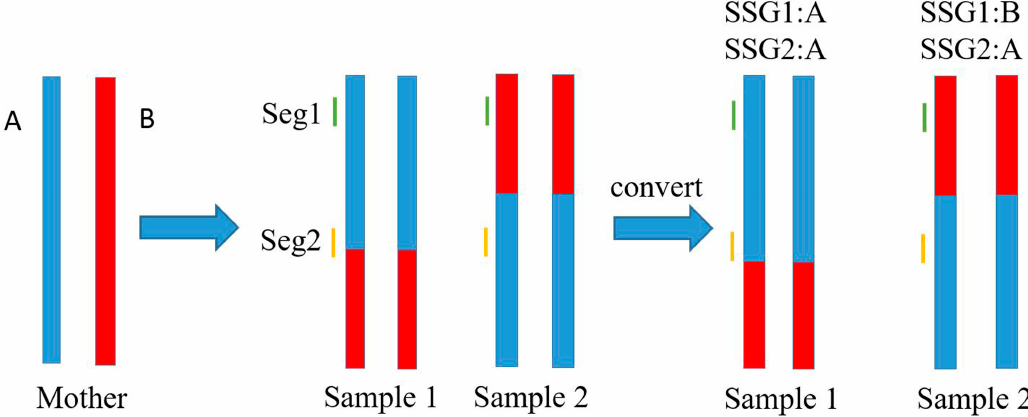
Figure 2. Schematic illustration of the conversion of SSGs under different circumstances. The maternal chromatids possess linkage phase score A (blue) and B (red). In Sample 1, recombination occurs on Seg2 but outside of Seg1. In Sample 2, recombination occurs outside of both Seg1 and Seg2, which is the most common case.